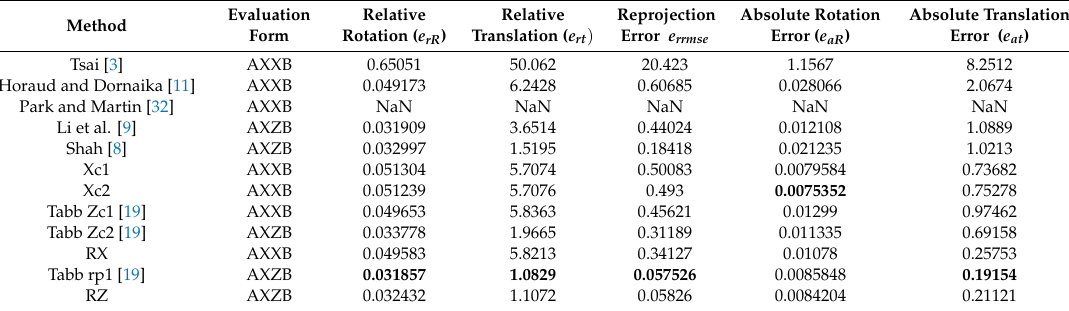
Table 4. Comparison of methods using the described error metrics for dataset